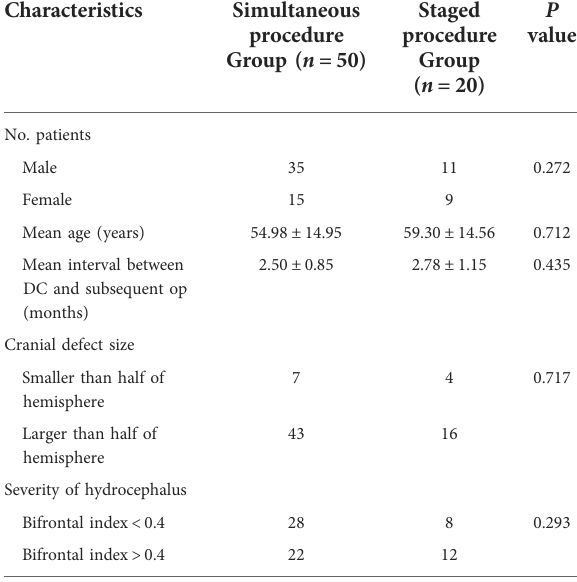
TABLE 1 Patient demographics and clinical